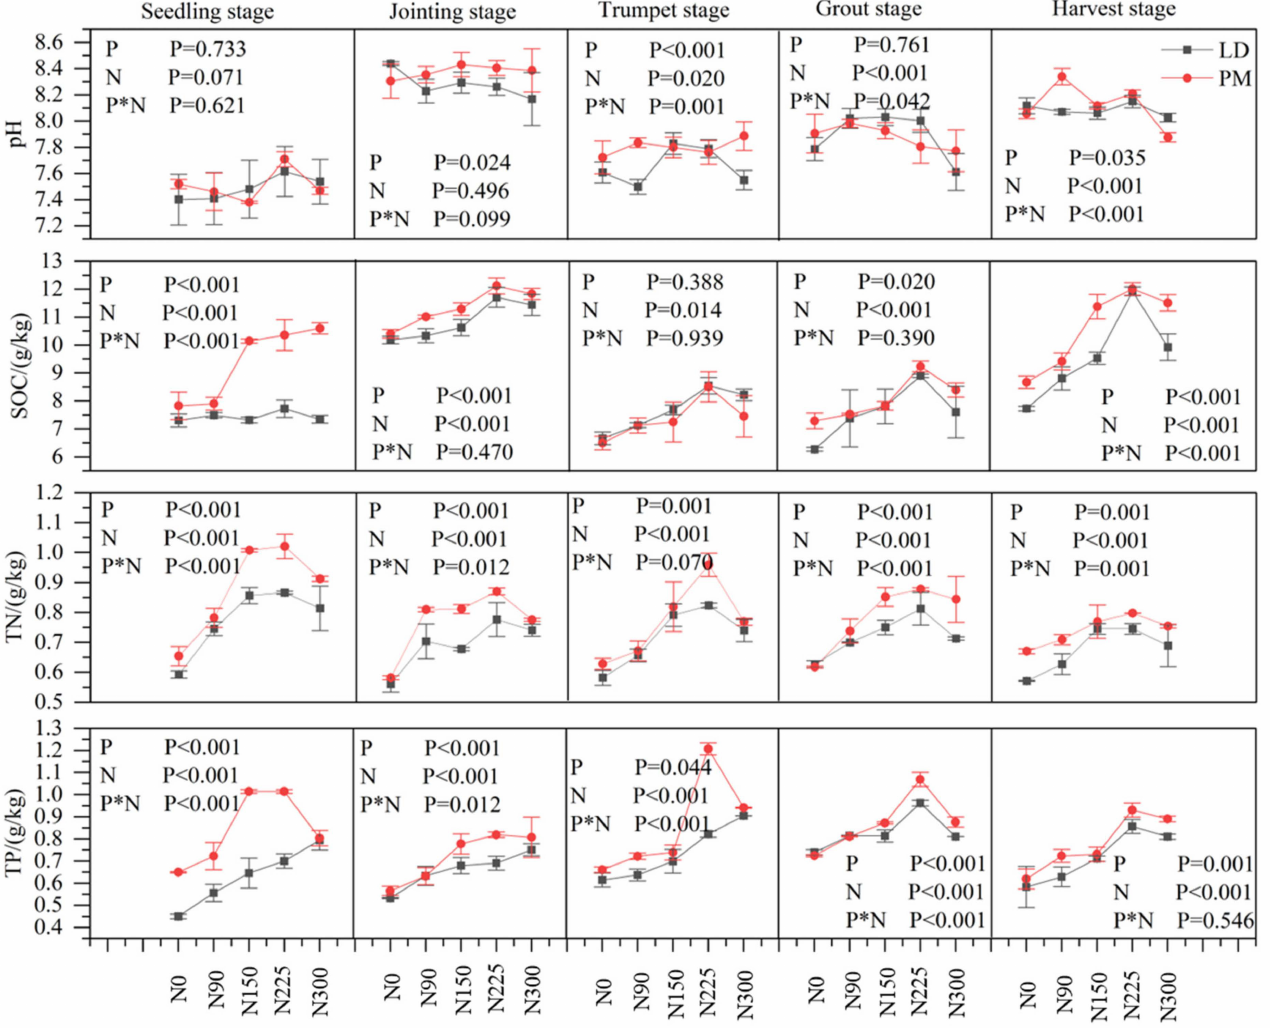
Figure 1. Physical and chemical properties of soil under the different treatments. SOC, soil organic carbon; TN, total carbon; TP, total phosphorus; P, plastic film mulching; N, nitrogen levels (0, 90, 150, 225, and 300 kg · hm − 2 ); P*N, plastic film mulching * nitrogen levels; N0, nitrogen application level was 0 kg · hm − 2 ; N90, nitrogen application level was 90 kg · hm − 2 ; N150, nitrogen application level was 150 kg · hm − 2 ; N225, nitrogen application level was 225 kg · hm − 2 ; N300, nitrogen application level was 300 kg · hm − 2